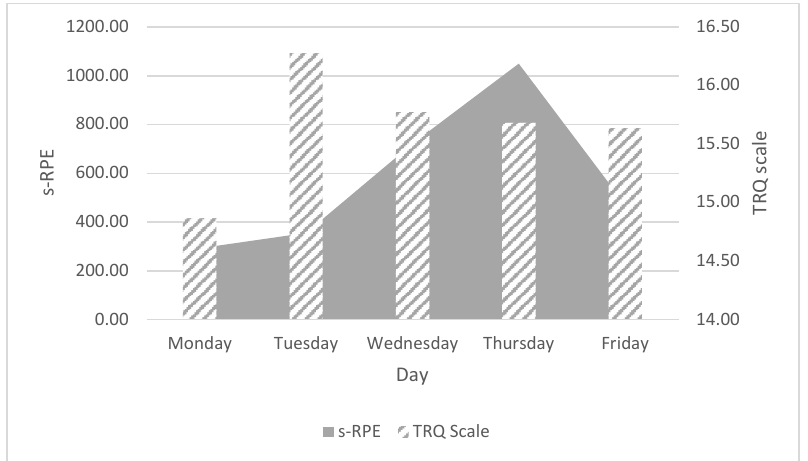
Figure 1. Relations between s-RPE and TRQ scale. Total Quality Recovery (TRQ Scale), Session Rating of Perceived Exertion (s-RPE).